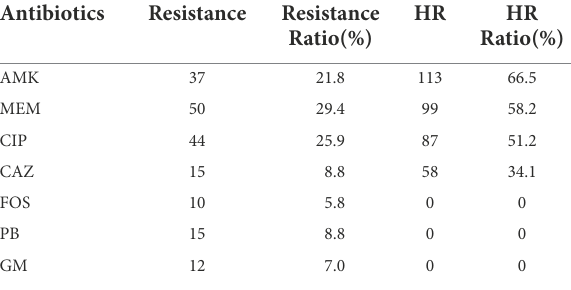
TABLE 1 Heteroresistance (HR) of clinical Pseudomonas aeruginosa isolates( n = 170). Antibiotics